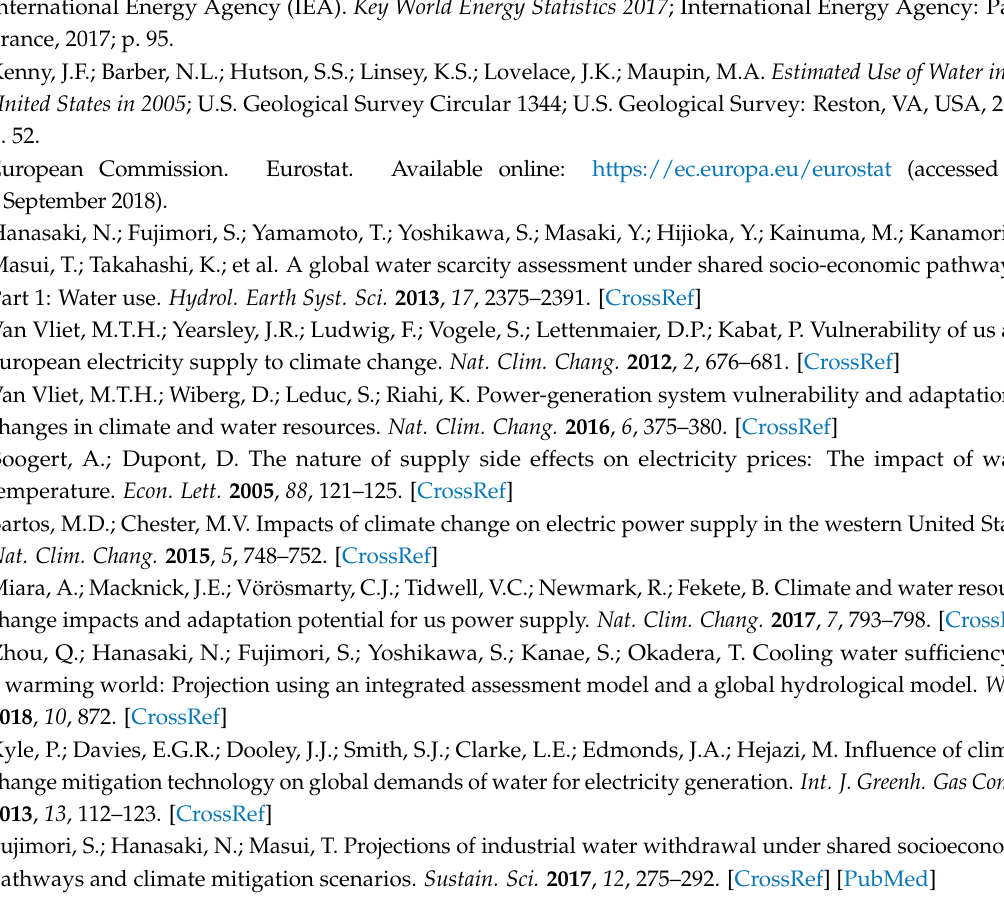
s1. Table S1: Regional classification and Table S2: Sectorial